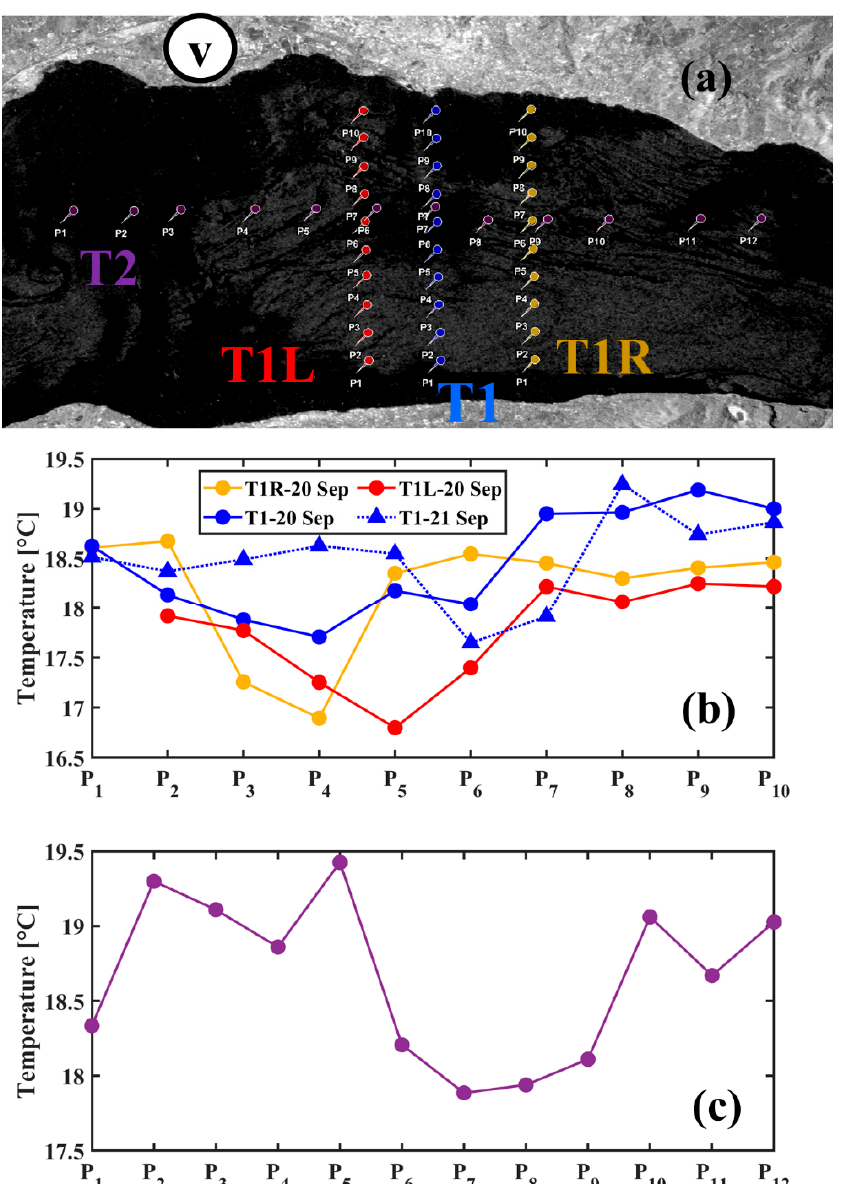
Figure 6. ( a ) Subset of a Sentinel-1A SAR-C image acquired on 20 September 2019 at 17:31 UTC. ( b ) Near surface temperature (1 m depth) measured along transects T1L, T1 and T1R. ( c ) Near surface temperature (1 m depth) measured along transect T2. The distance between measurement points is ~1.5 km, whereas it is ~1 km along T1L, T1 and T1R. V: reference point marked in Figure 1.